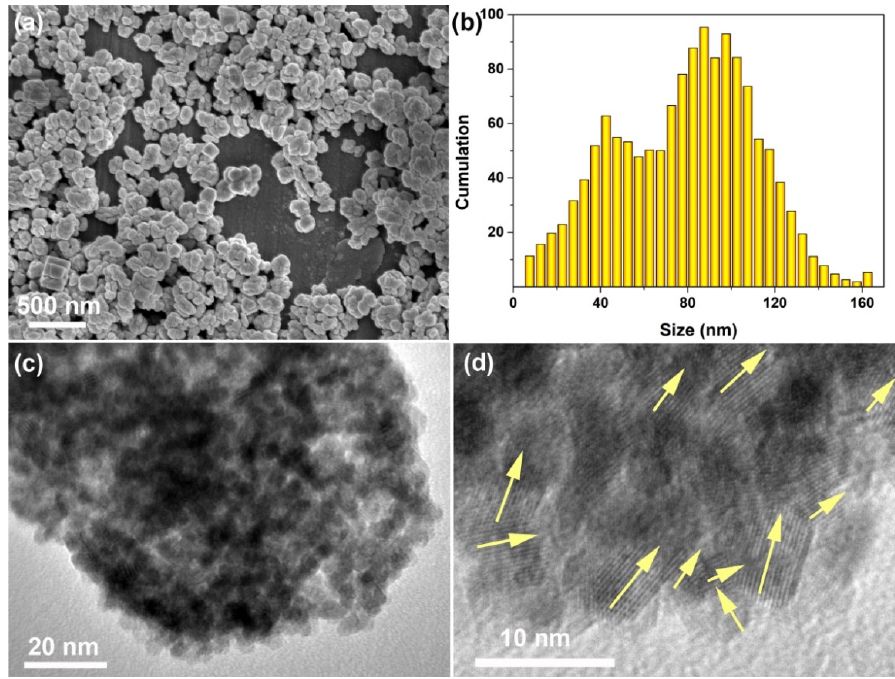
Figure 5. ( a ) SEM image, ( b ) size distribution histogram, ( c ) TEM and ( d ) HR − TEM images of CeO 2 particles hydrothermally synthesized at 200 °C for 24 h with 4 mmol guanidine carbonate and 4 mL 30% H 2 O 2 . (The yellow arrows in ( d ) are the direction of lattice fringes).